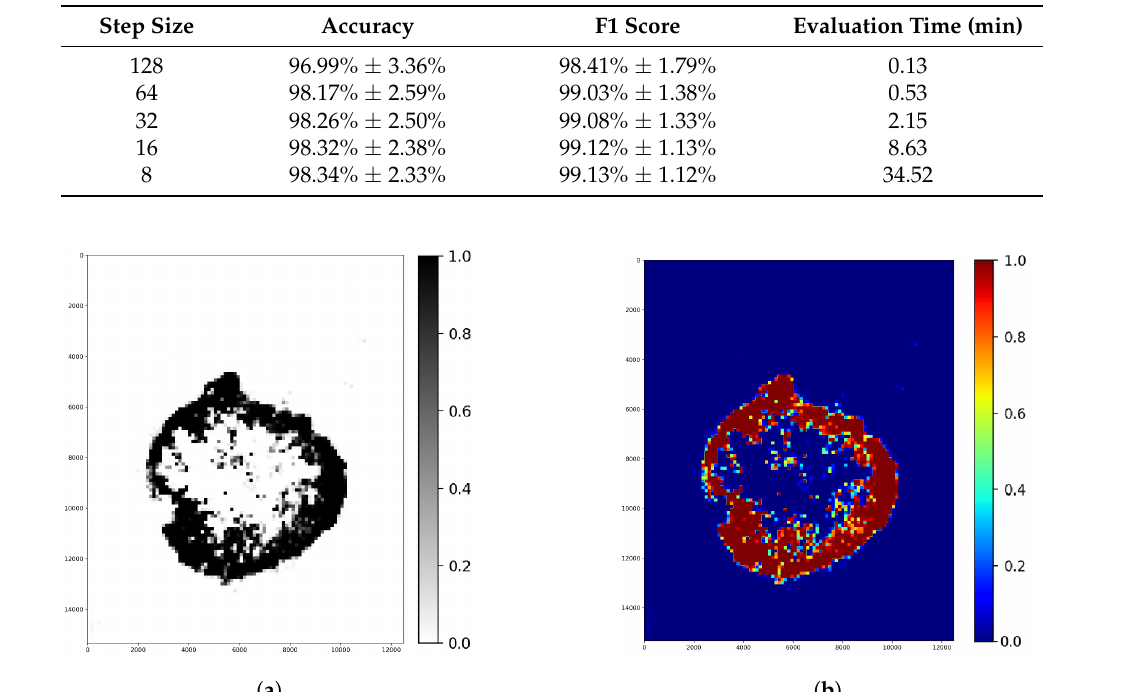
Table 2. Average evaluation performances and times at different step sizes on the threshold level of 0.13.